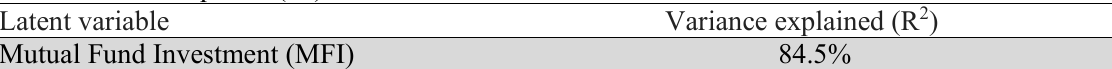
The results of R-Squared (R 2 )